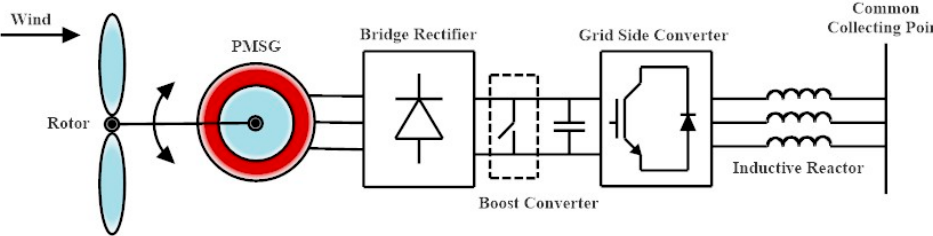
Figure 17. Generator-side uncontrolled rectifier with boost converter [58].